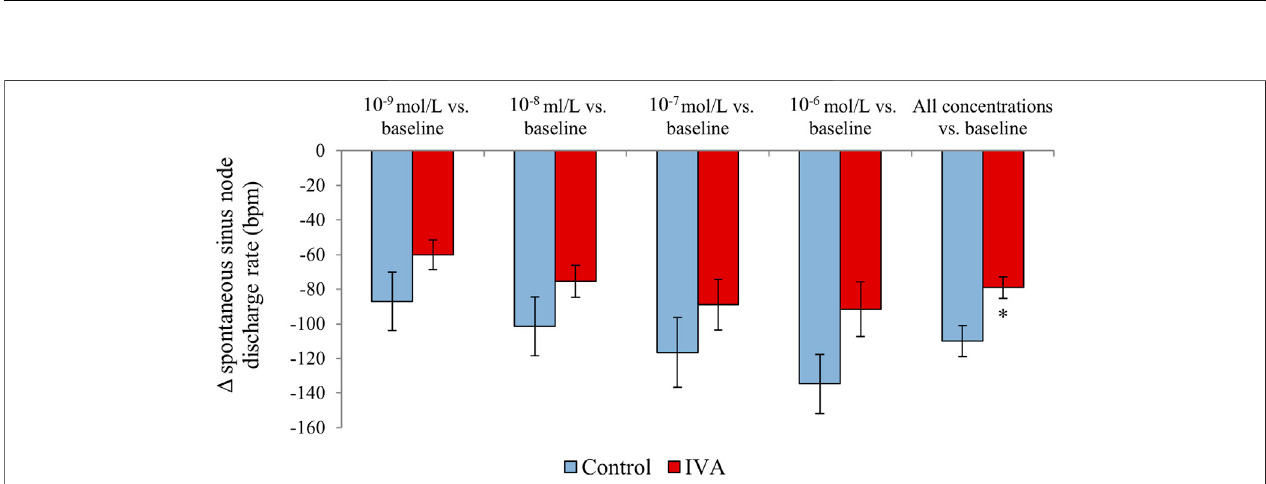
FIGURE 7 | Spontaneous sinus node discharge rate changes in response to in vitro carbamylcholine administration (10 − 9 to 10 − 6 mol/L) compared with the baseline values in the ivabradine-treated (IVA; n (cid:2) 10) and non-treated (Control; n (cid:2) 6) rats.